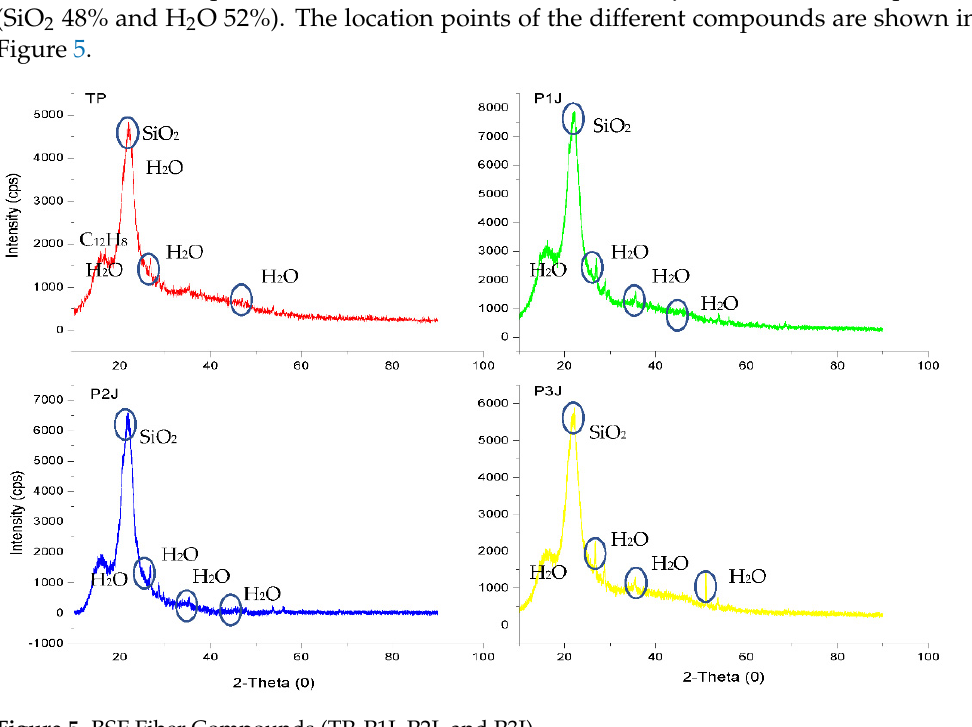
Figure 5. BSF Fiber Compounds (TP, P1J, P2J, and P3J).